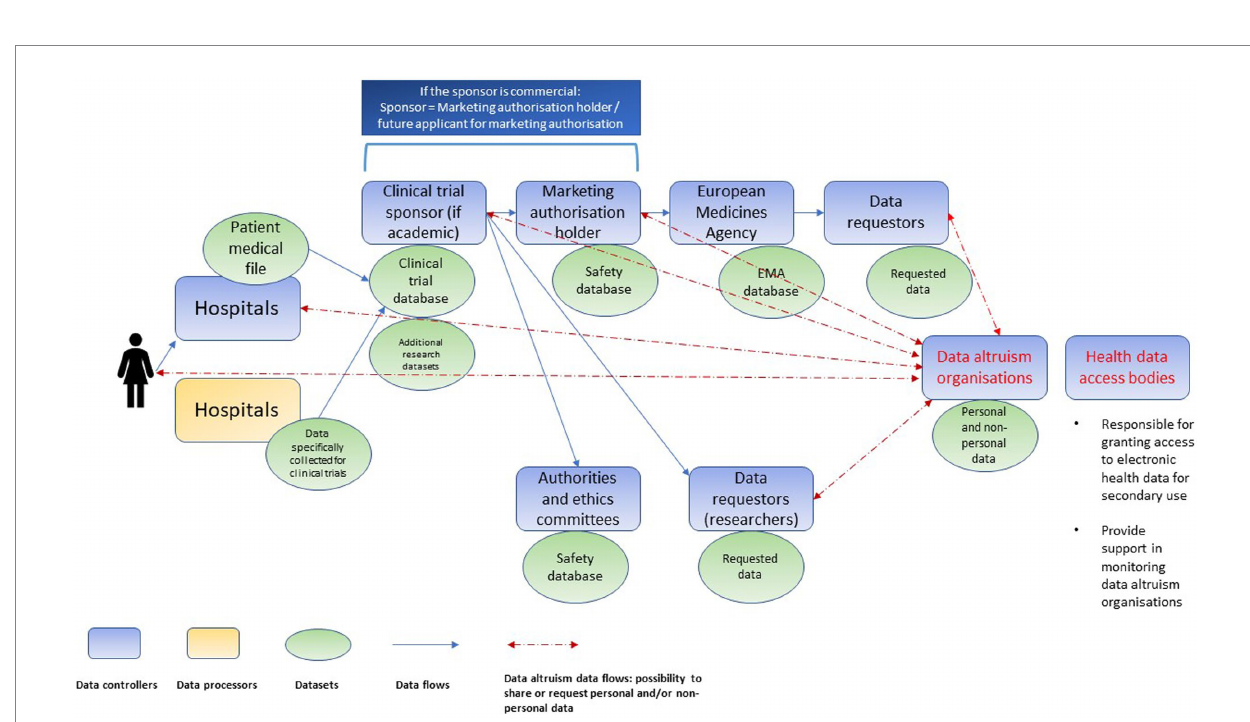
FIGURE 2 Chain of independent data controllers in clinical trials after the introduction of data altruism organizations and health data access bodies (non- exhaustive